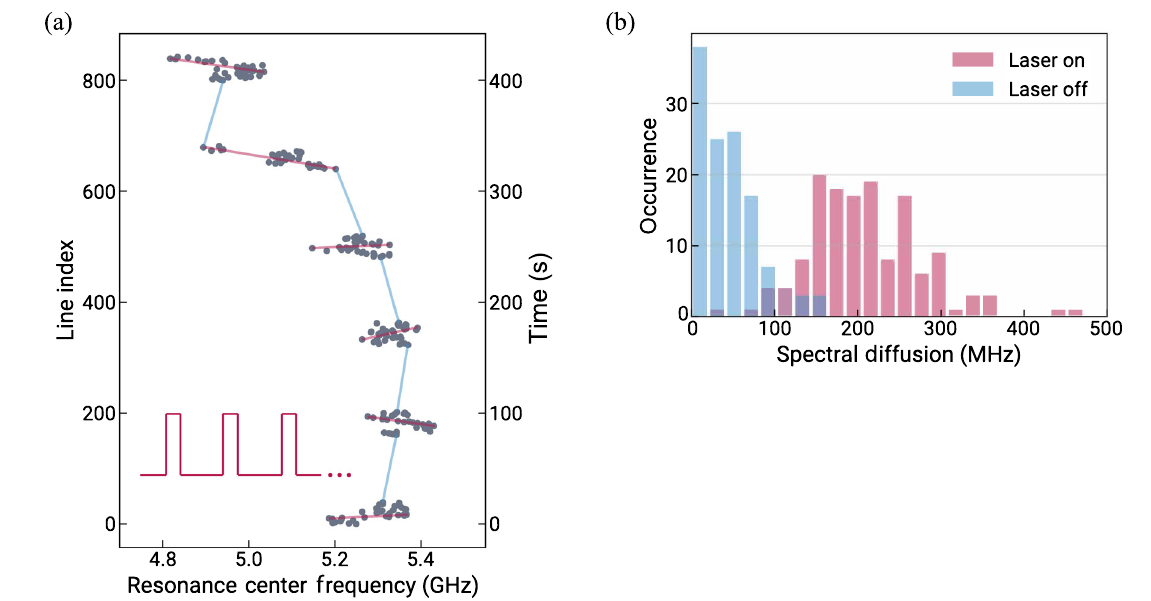
FIG. 4. NV in the dark (regime 3). (a) Shutter experiment in which we alternate between PLE scanning for 20 s and blocking the radiation for 60 s. When PLE scans are performed, the center frequency of the ZPL resonance is extracted from Voigt fits (gray dots). Here, a data set is exemplarily presented. (b) Occurrence of spectral shifts obtained from many data sets. The extracted spectral diffusion value for “ Laser on ” corresponds to the spanned frequency range recorded in a period of 20 s. The spectral diffusion for “ Laser off ” is extracted from the spectral difference of the last PLE scan before and the first scan after blocking the laser, as illustrated in panel